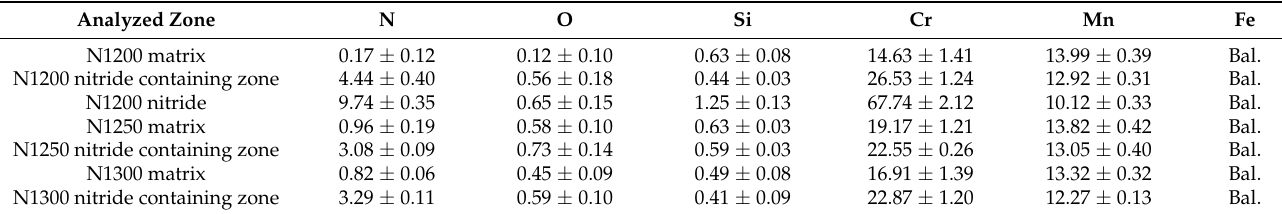
Table 3. EDS results of porous samples N1200, N1250, and N1300, wt.%.